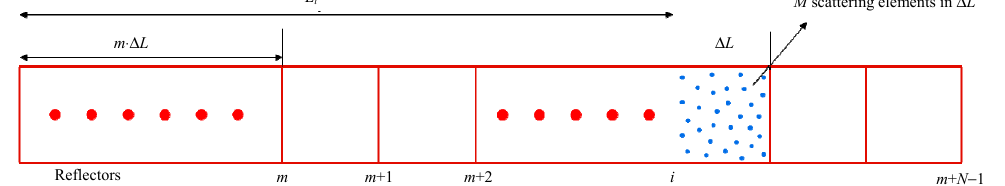
Fig. 1 Interference model of Φ -OTDR